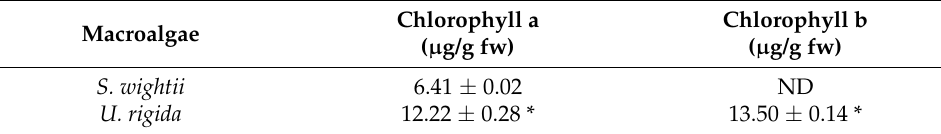
Table 1. Chlorophyll contents of macroalgae S. wightii and U. rigida